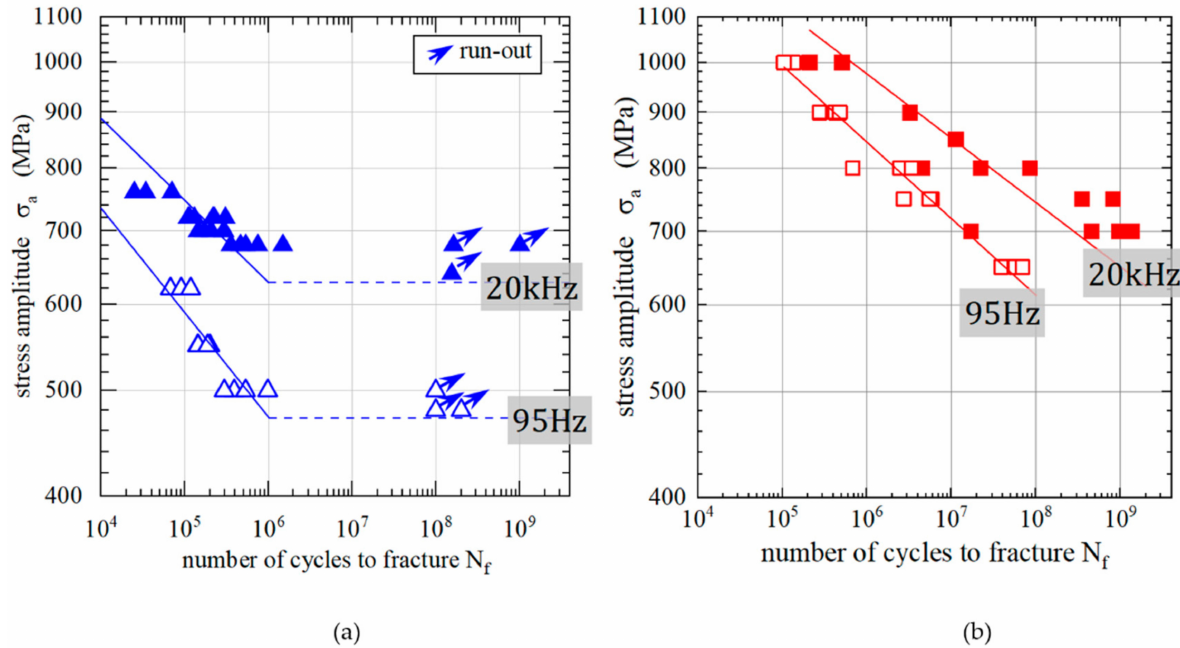
Figure 9. Wöhler S-N Diagram showing the fatigue life for the steel 50CrMo4 at two testing fre- quencies of f = 95 Hz and f = 20 kHz for ( a ) the 37HRC hardness condition, and ( b ) the 57HRC hardness